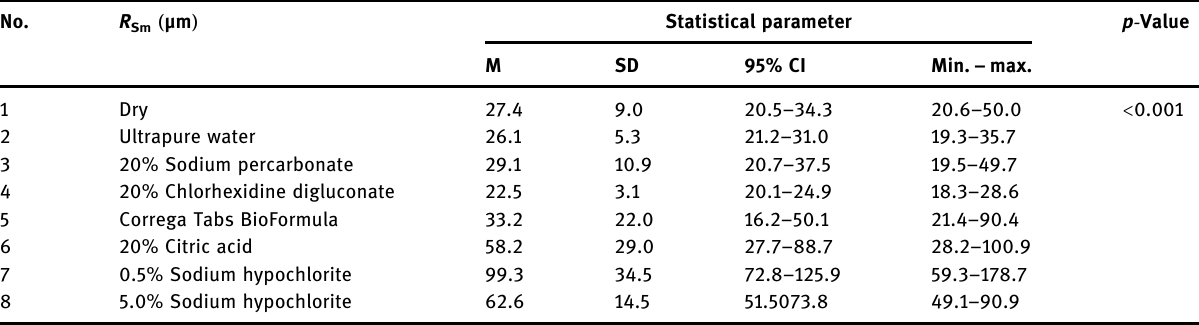
Table 6: Descriptive statistics for R Sm measurements